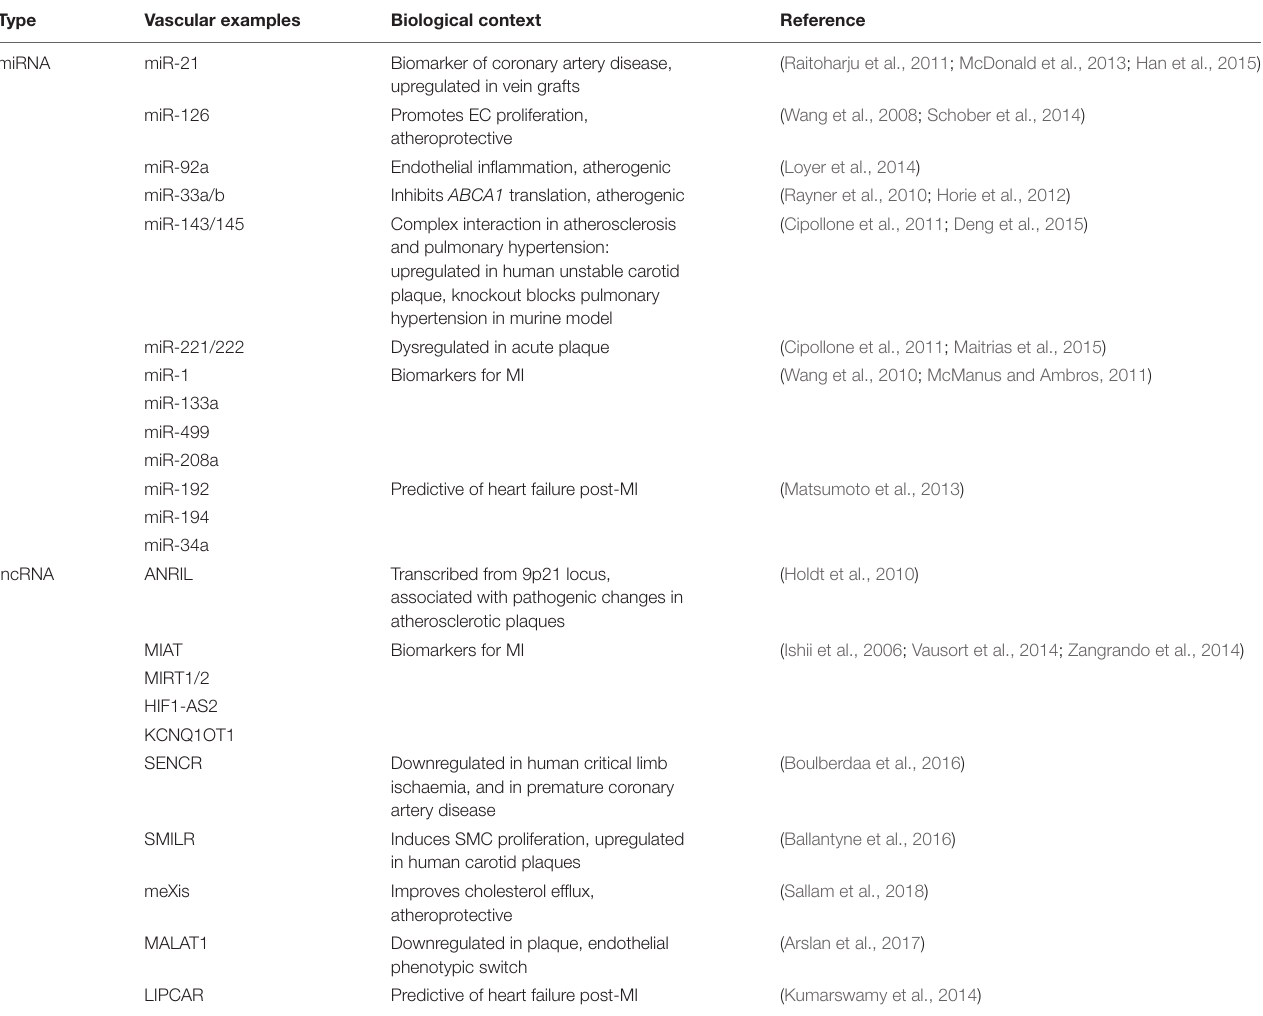
TABLE 1 | Non-coding RNA in vascular